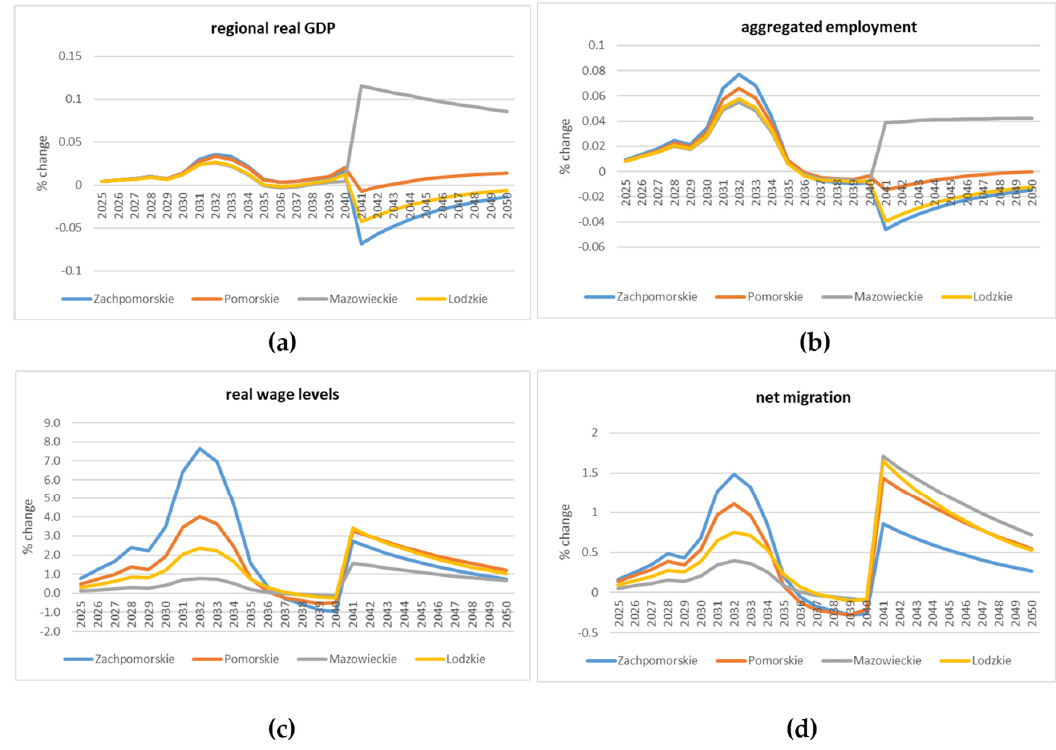
Figure 5. Regional results of building nuclear plants in each region, showing percent changes compared to the baseline in: ( a ) real GDP; ( b ) aggregated employment; ( c ) real wages and ( d ) net